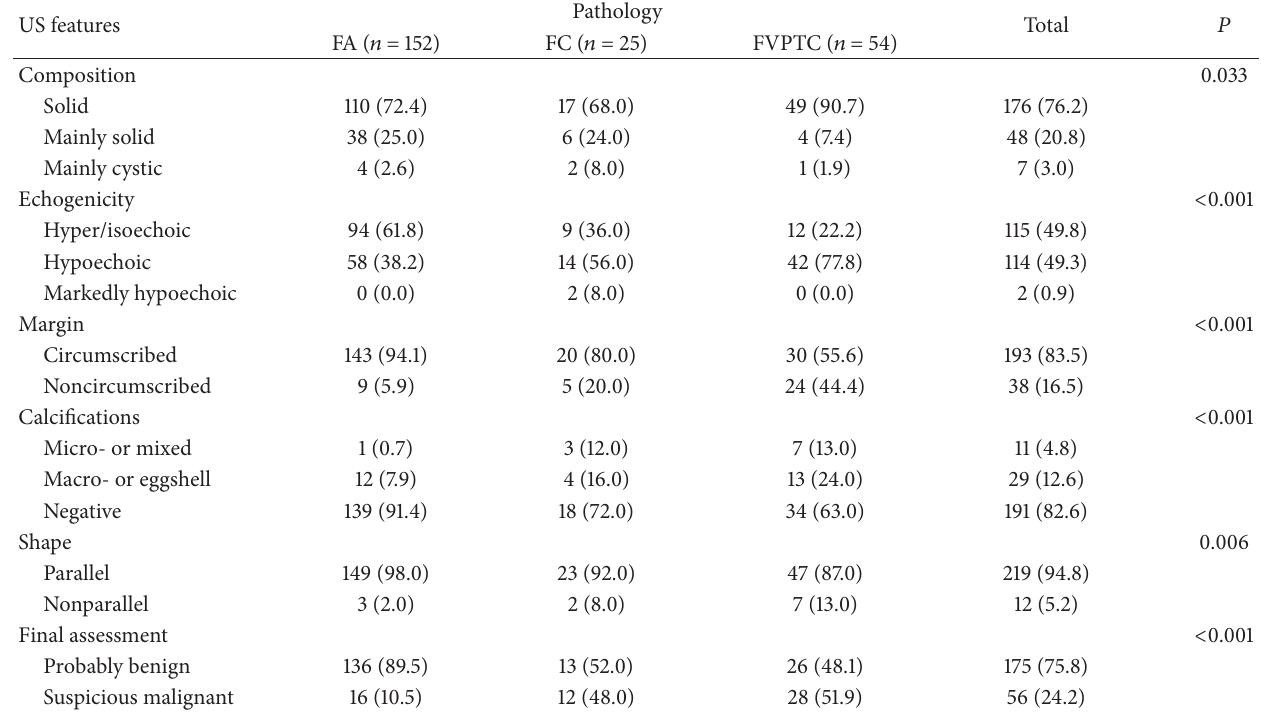
Table 2: Comparison of US features among the 231 thyroid nodules diagnosed as follicular adenoma, follicular carcinoma, and follicular variant of papillary thyroid